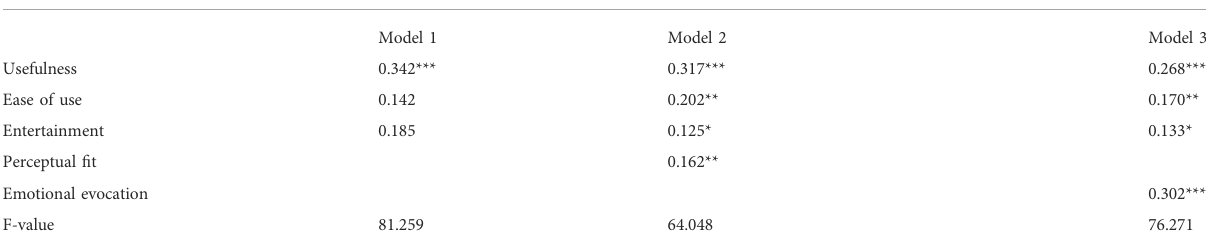
TABLE 4 Mediation effect